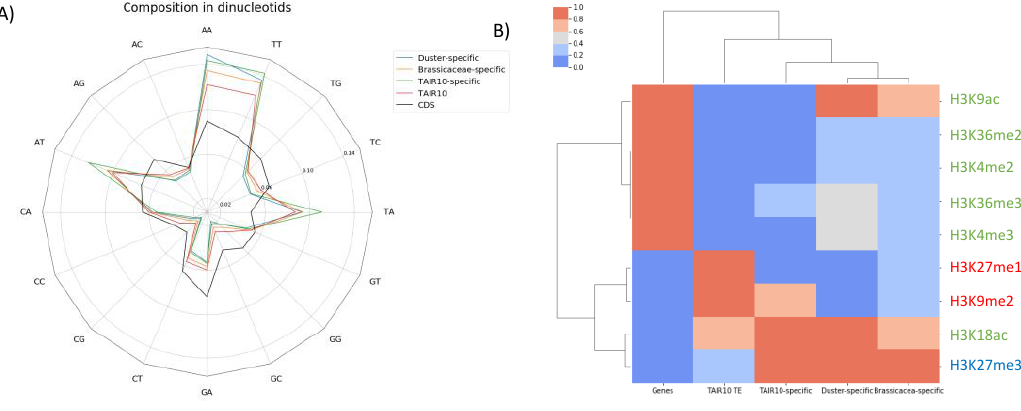
Figure 3 : Composition of Duster-specific, Brassicaceae-specific, and TAIR10-specific copies. (A) Radar plot of the dinucleotide composition of the sequences. (B) Hierarchical clustering of TEs and genes with respect to heterochromatin marks (H3K27me1 and H3K9me2) and euchromatin marks (H3K18ac, H3K27me3, H3K36me2, H3K36me3, H3K4me2, H3K4me3,